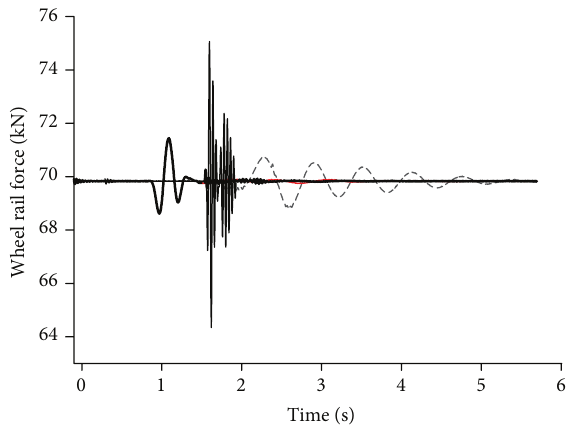
Figure 10: Vertical wheel/rail force corresponding to different exci- tations. Bold line: voided sleeper; solid line: weld joint irregularity; dashed line: sinusoidal excitation.